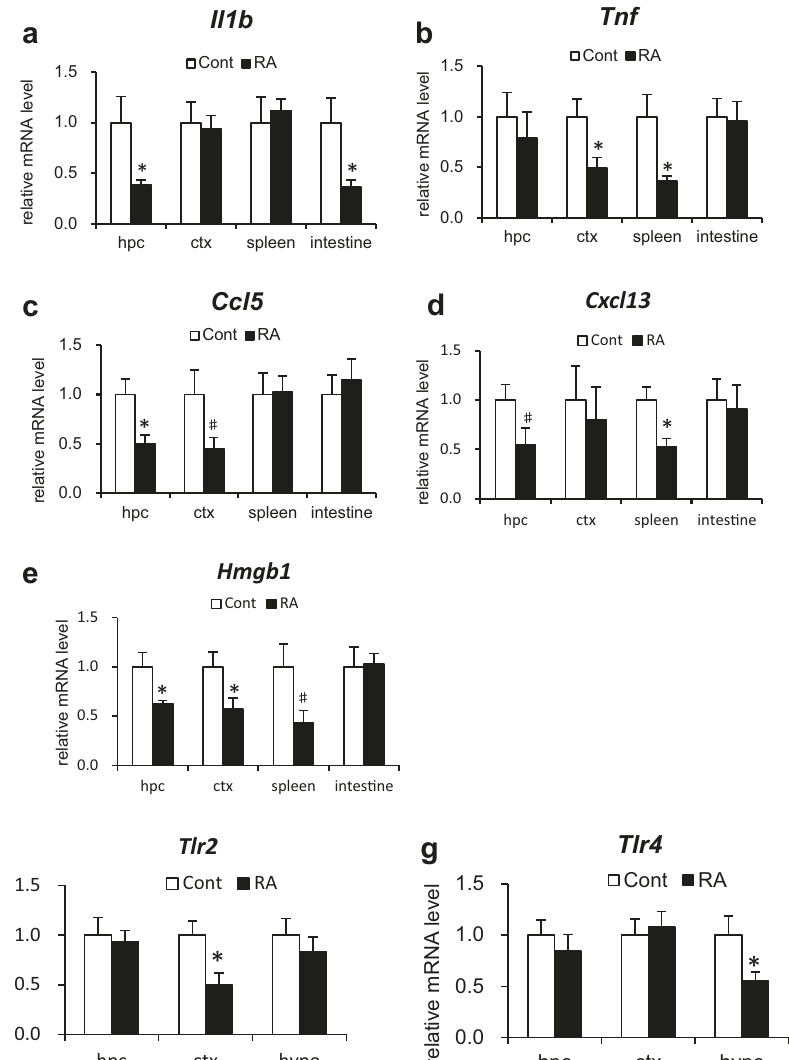
Fig. 7 RA reduces systemic in fl ammation. a – e Expression levels of in fl ammatory mediators in hippocampus (hpc), cerebral cortex (ctx), spleen, and small intestine determined by qRT-PCR. Il-1b ( a ), Tnf ( b ), Ccl5 ( c ), Cxcl13 ( d ), and Hmgb1 ( e ). f – g Expression levels of Tlr2/4 in hpc, ctx, and hypothalamus (hypo) determined using qRT-PCR. All mRNA species were quanti fi ed relative to the expression of Gapdh and presented as fold changes compared to control (Cont). Data are shown as means ± standard error. Cont, n = 8; RA, n = 9, * p < 0.05, # p <